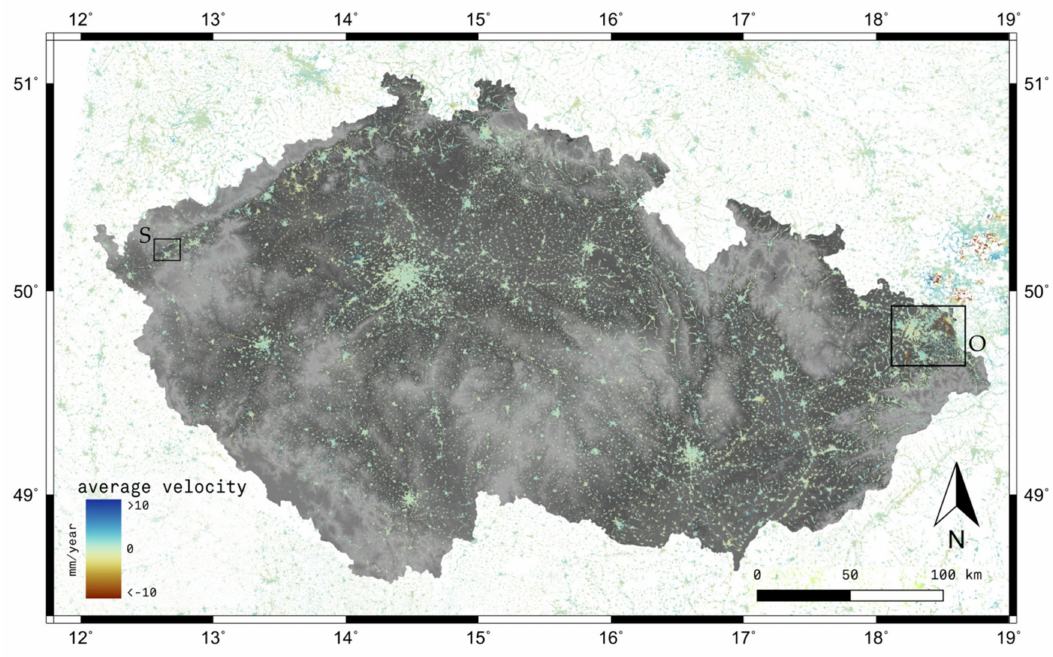
Figure 6. Nation-wide STAMPS PS processing output over Czechia, using IT4S1 system. Letters S, O indicate areas of Sokolov (Figure 4) and Ostrava (Figure